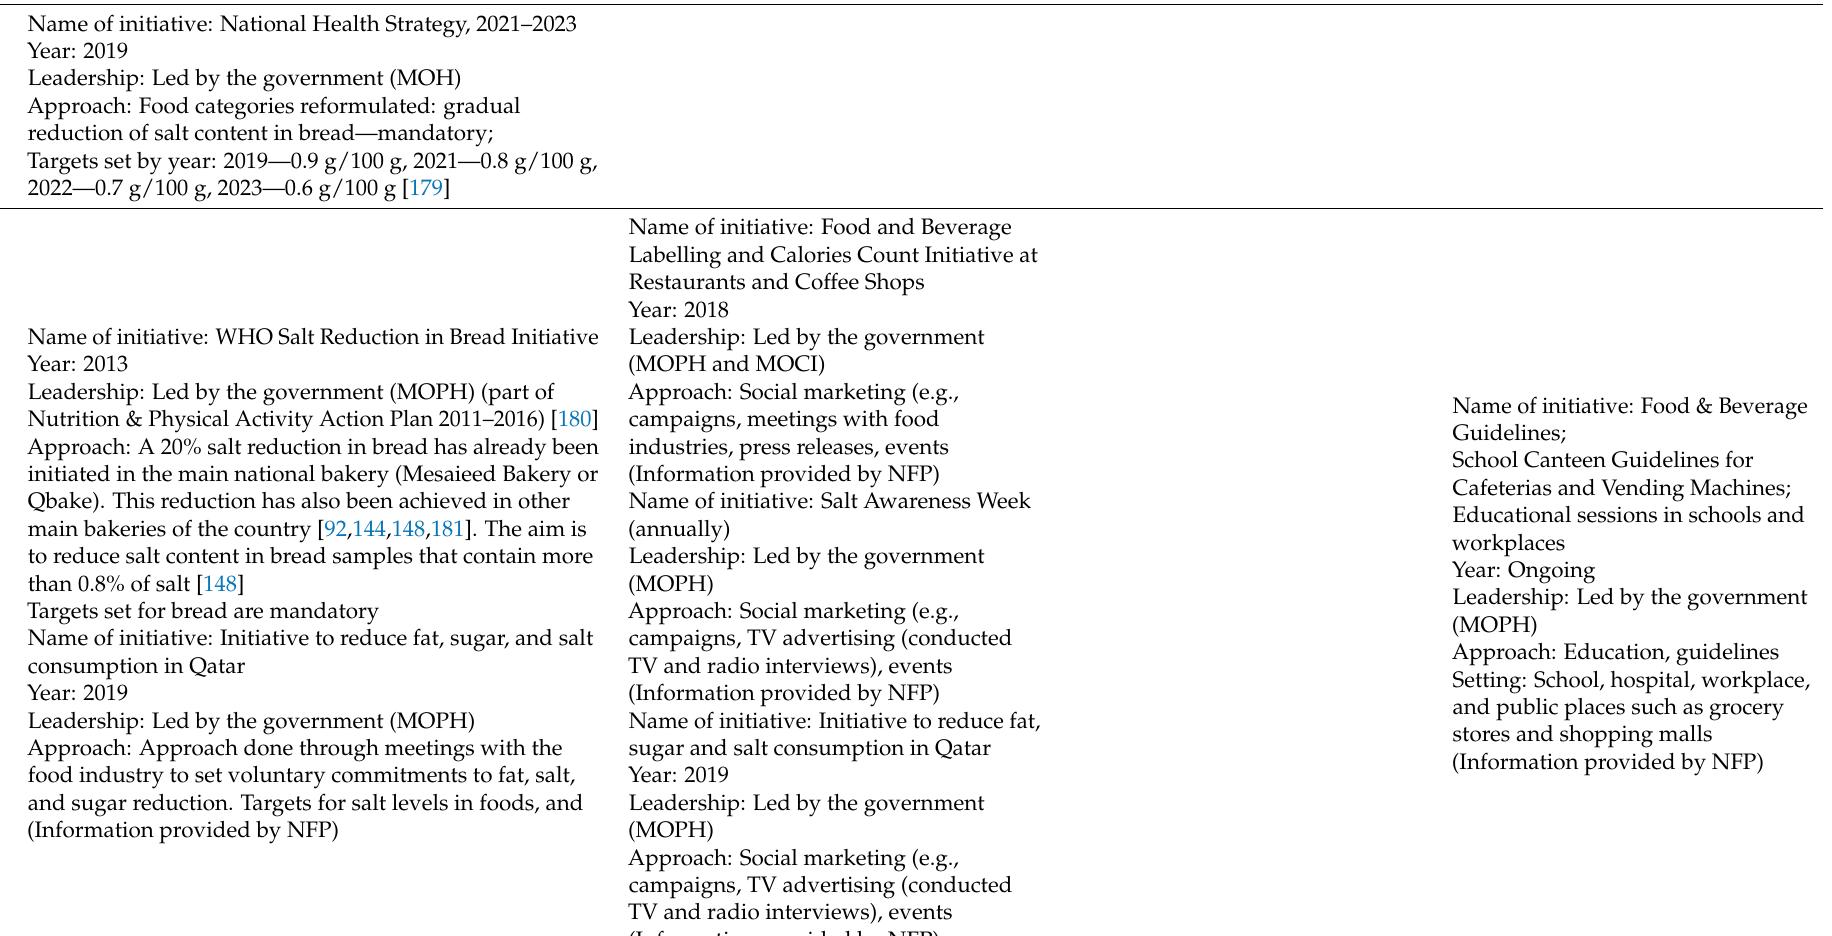
Consumer Education Front of Pack Labelling Work in Specific